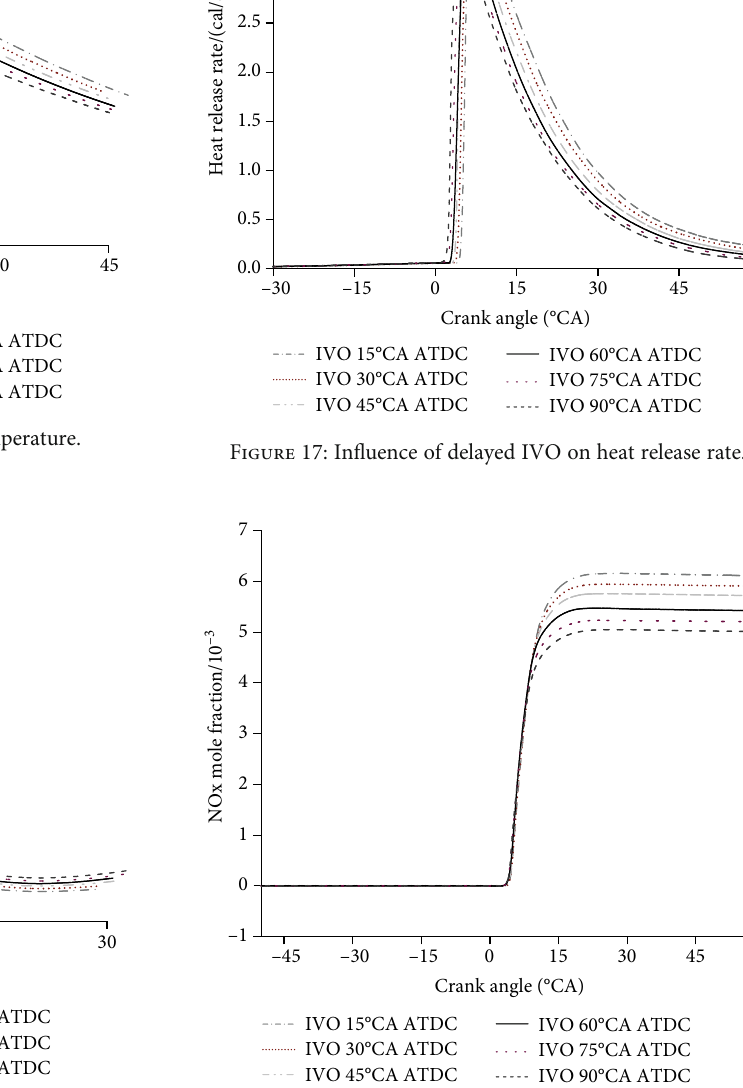
Figure 18: In fl uence of delayed IVO on NO